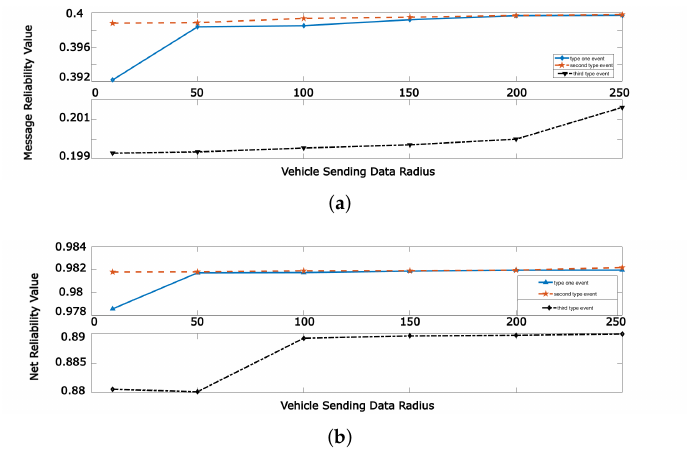
Figure 9. Message and net reliability values for different vehicle’s radius. ( a ) Message Reliability;